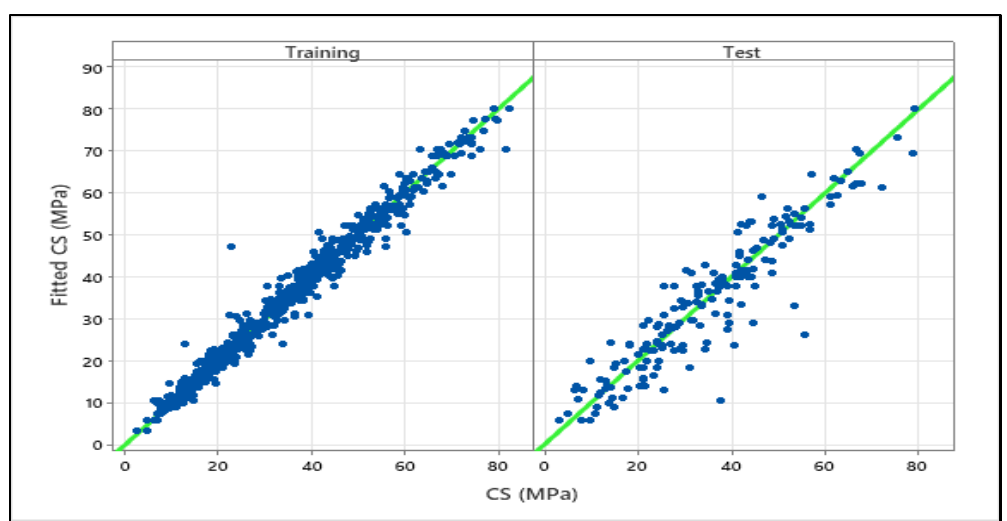
Figure 6. Predicted and Actual Values of CS During the Training and Testing Phase.